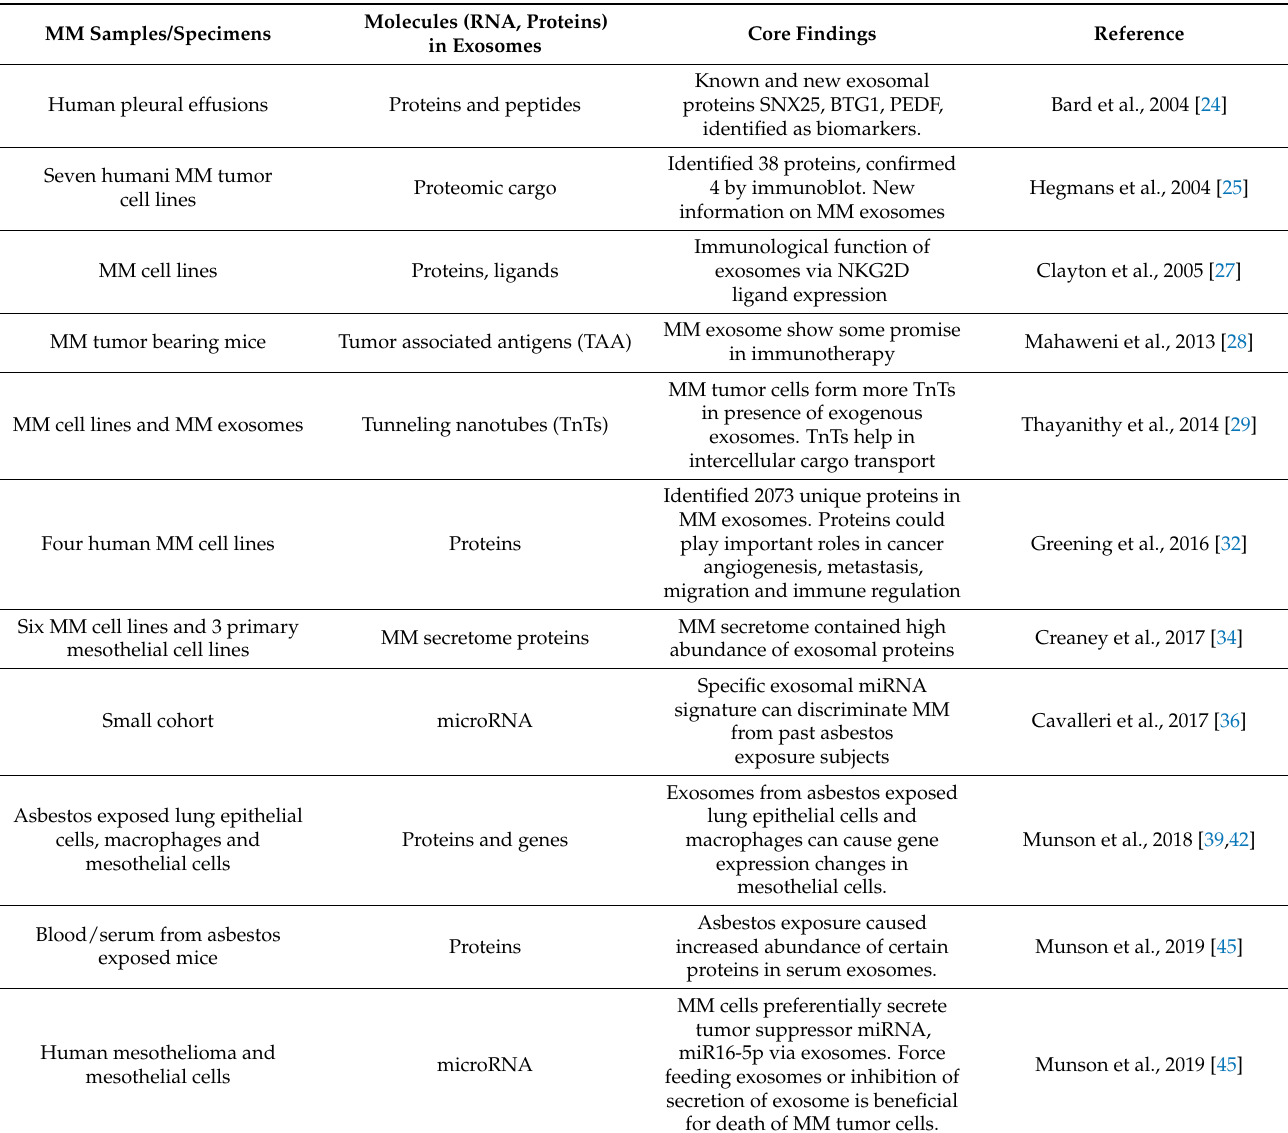
Table 1. A summary of exosome-related studies in the field of malignant mesothelioma